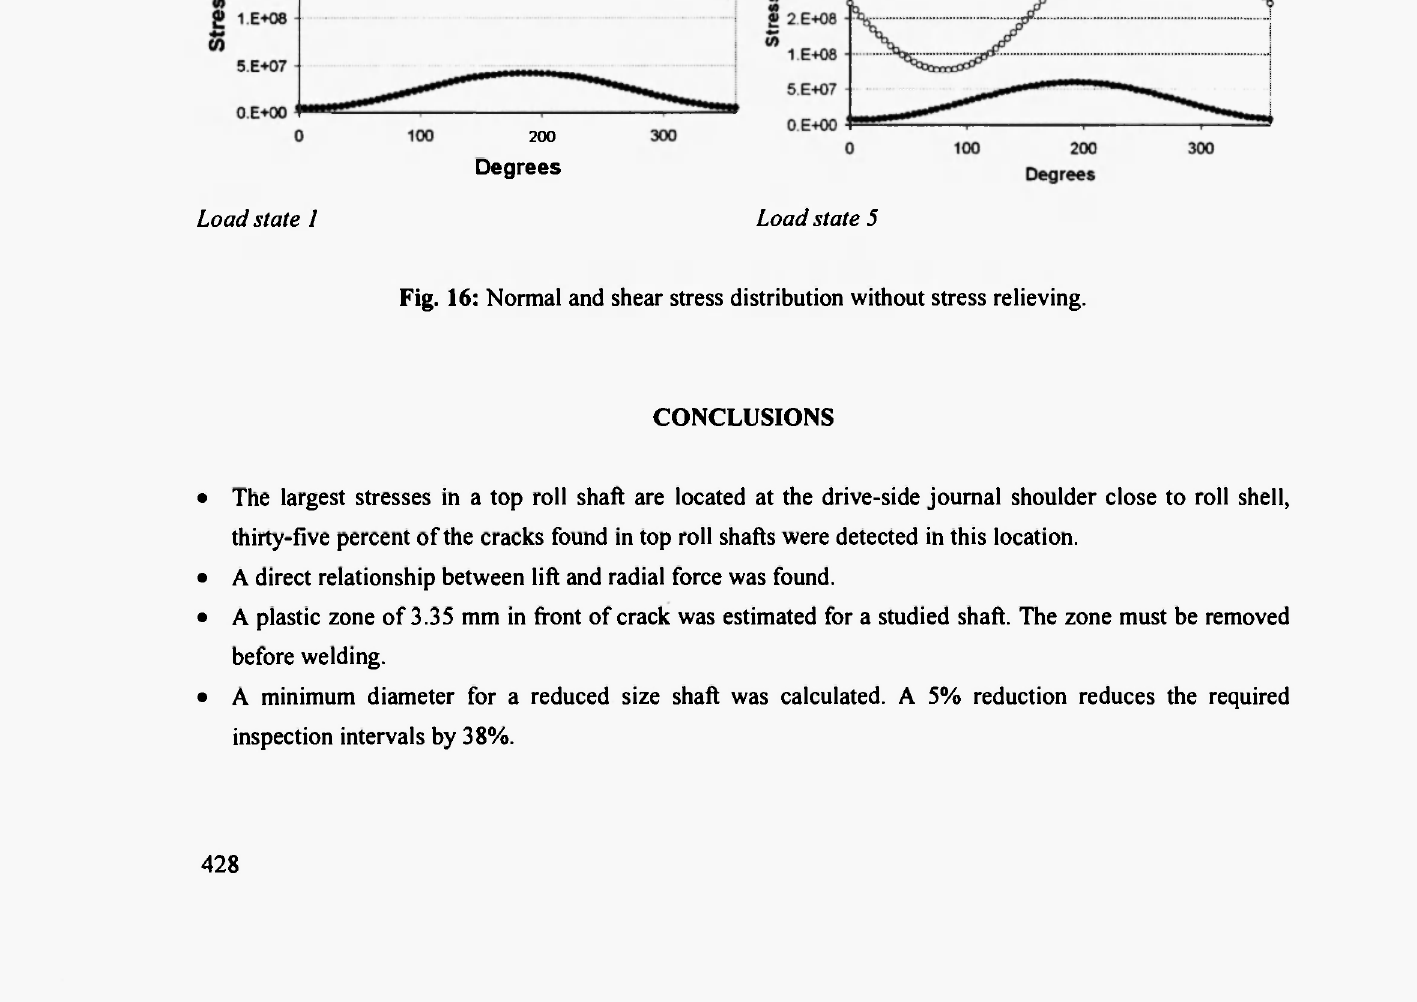
Fig. 15: Normal and shear stress distribution in the journal after a stress relieving treatment.